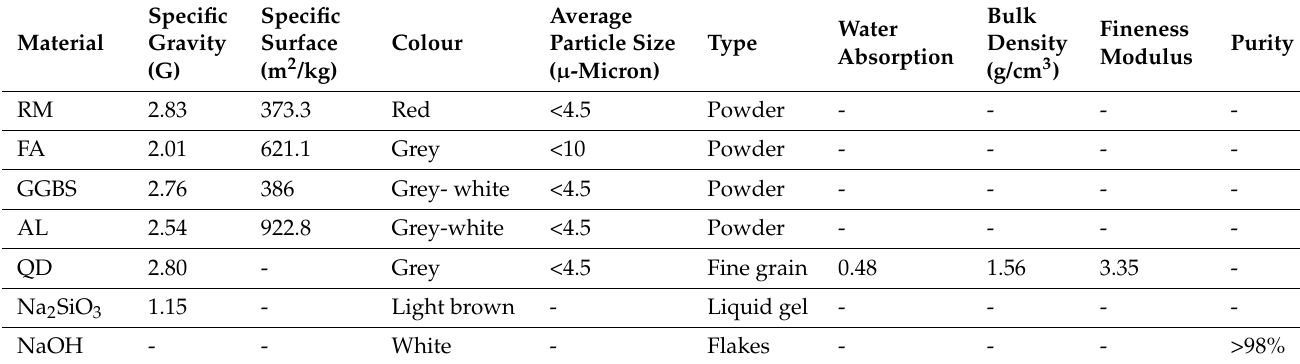
Table 2. Chemical composition of red